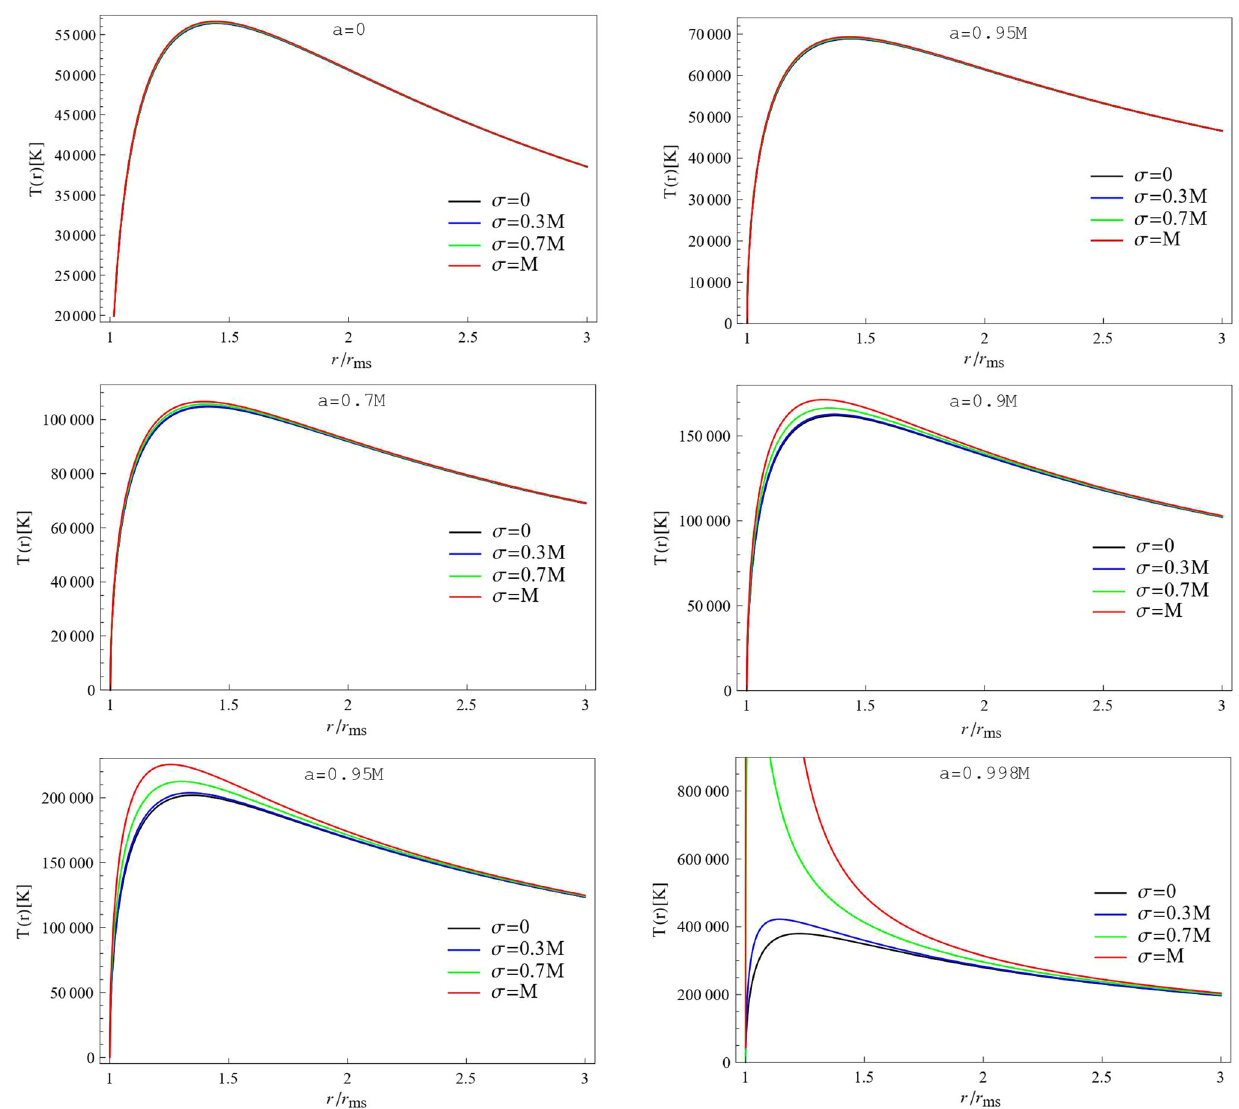
Fig. 2 Variation of temperature with distances away from r ms From Table 2, we can see the exact ratios of the flux emissivity maxima F max ( r ) as both spin and charge increase. Figure 1c ( middle left ) shows that the spin effect ( a / M = 0 . 7) is barely appreciable, the ratios of fluxes ( r )/ F Kerr ( r ) = 1 . 07, which shows only a become F BG max max slight increase from the Kerr values. Figure 1d ( middle right ) shows that the higher spin effect ( a / M = 0 . 9) beginning to become noticeable - the flux ratios become ( r )/ F Kerr ( r ) = 1 . 25. Similarly, Fig. 1e ( bottom left ) F BG max max shows the spin effect ( a / M = 0 . 95) causes the flux ratio to ( r )/ F Kerr ( r ) = 1 . 56. Profile patterns in Fig. 1f ( bot- be F BG max max tom right ) for ( a / M = 0 . 998) and ( σ/ M = 1) show that the radiation flux from the BG singularity attains a huge value, ( r )/ F Kerr ( r ) = 4 . 48 × 10 5 (as can be read off that is, F BG max max